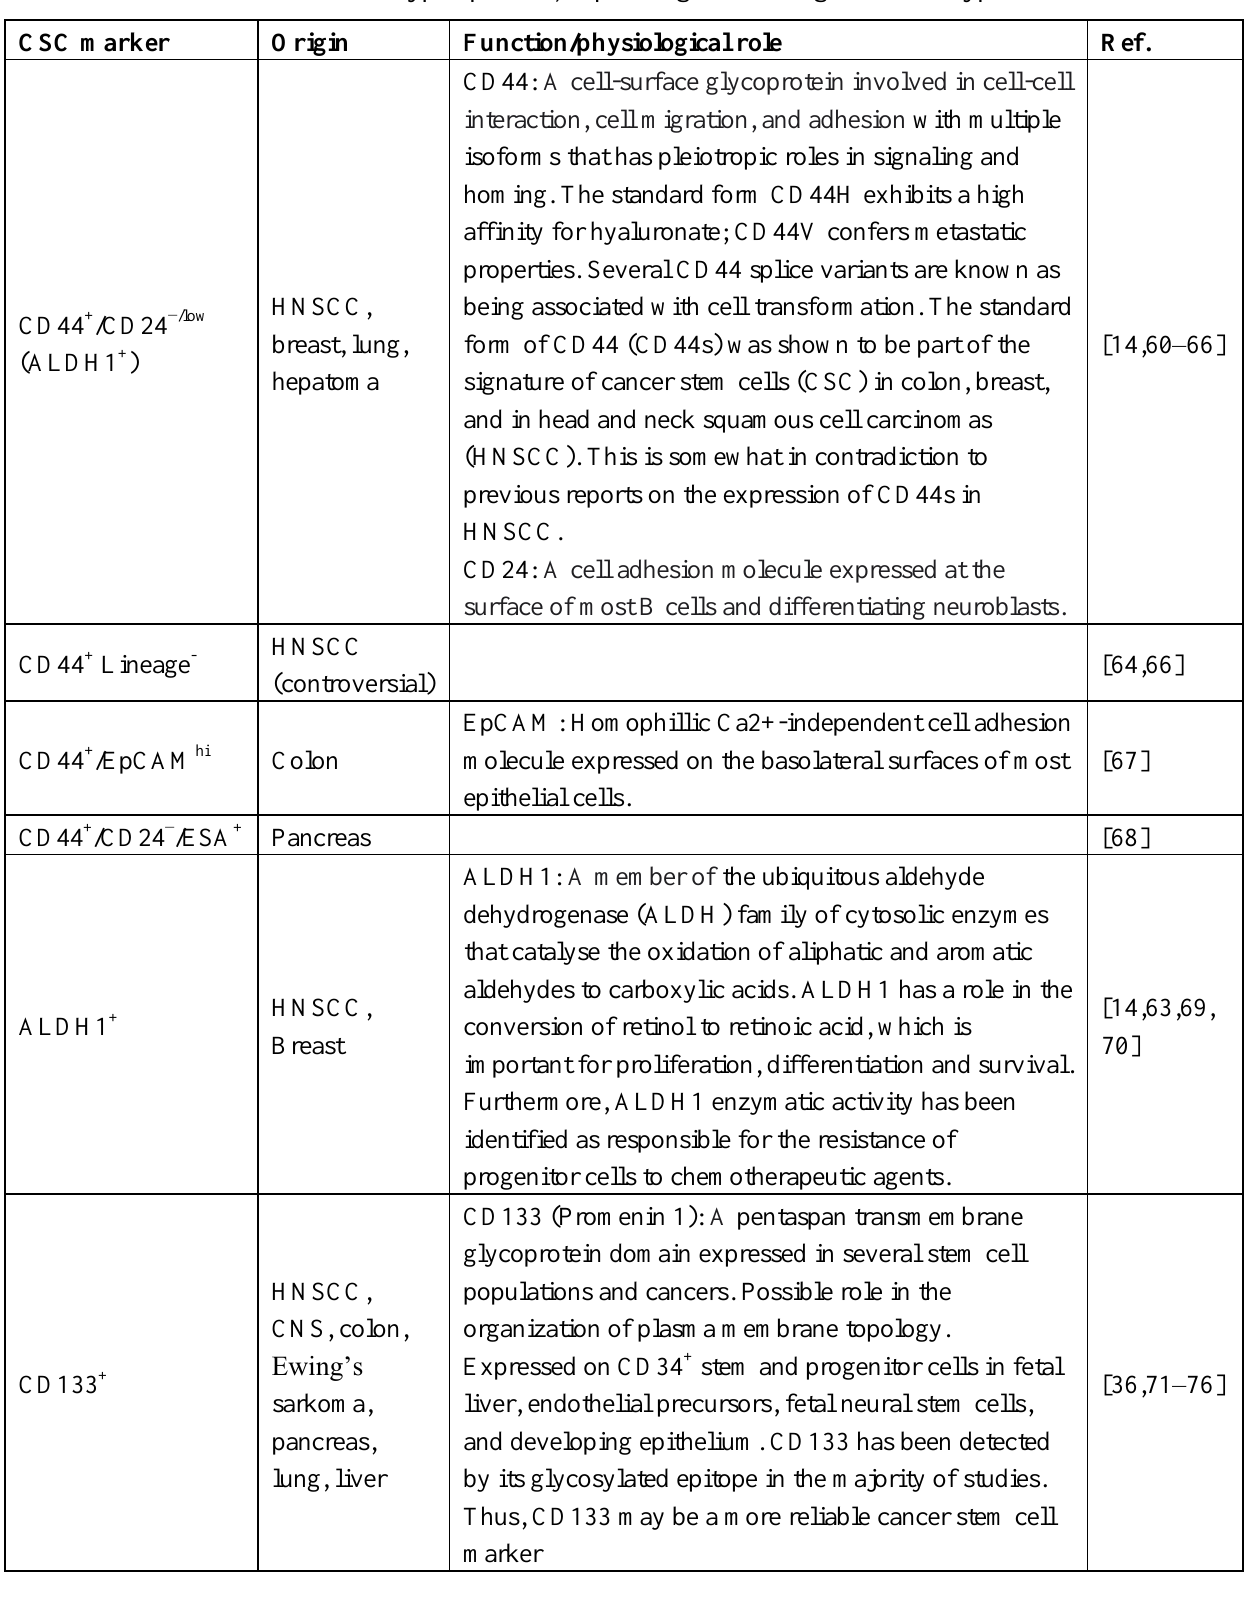
Table 1. Cancer stem cell markers of HNSCC and other solid tumors. To date, no generic marker for all CSC has been described. CSC of different tumor entities have distinct markers that do not always overlap. The future will reveal whether a universal CSC marker exists or if CSC are tumor-type specific, depending on the origin of each type of CSC.